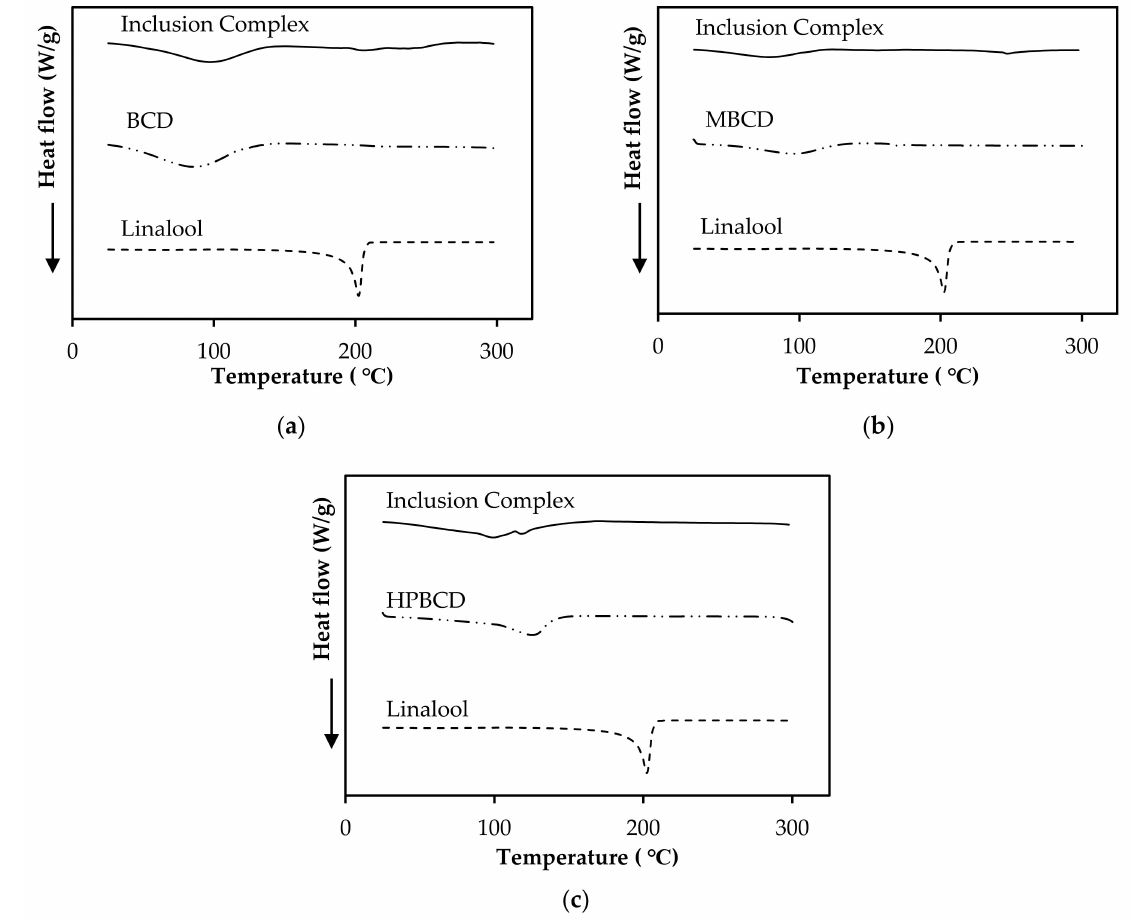
Figure 16. DSC curves of ( a ) linalool/BCD inclusion complex, BCD, and linalool; ( b ) linalool/MBCD inclusion complex, MBCD, and linalool; ( c ) linalool/HPBCD inclusion complex, HPBCD, and